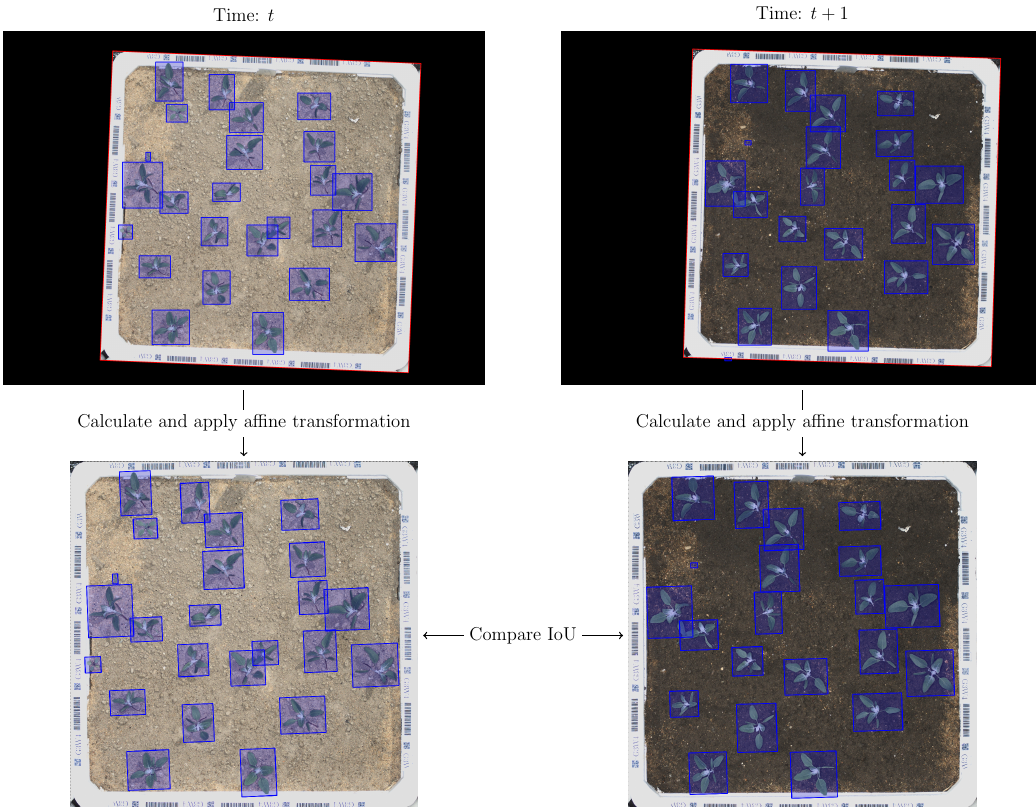
Figure 4. Matching bounding boxes example. For each image, an affine transformation was calculated to map the boxes into a common coordinate system. The bounding boxes in two temporal succeeding frames was matched if the Intersection over Union (IoU) between them were